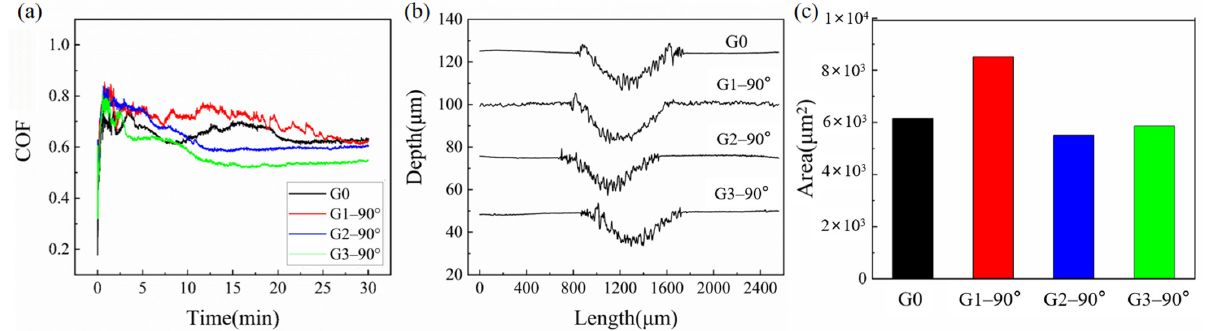
Figure 8. The COF ( a ) and wear section ( b ) and its area ( c ) of YG6X with different texture spacings under the sliding direction of the Si 3 N 4 ball perpendicular to the groove texture